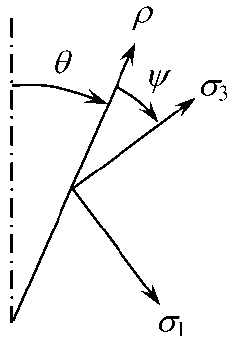
Figure 2. Orientation of the principal stresses. The transformation equations for the components of tensors in a generic ( ρ , θ ) plane lead